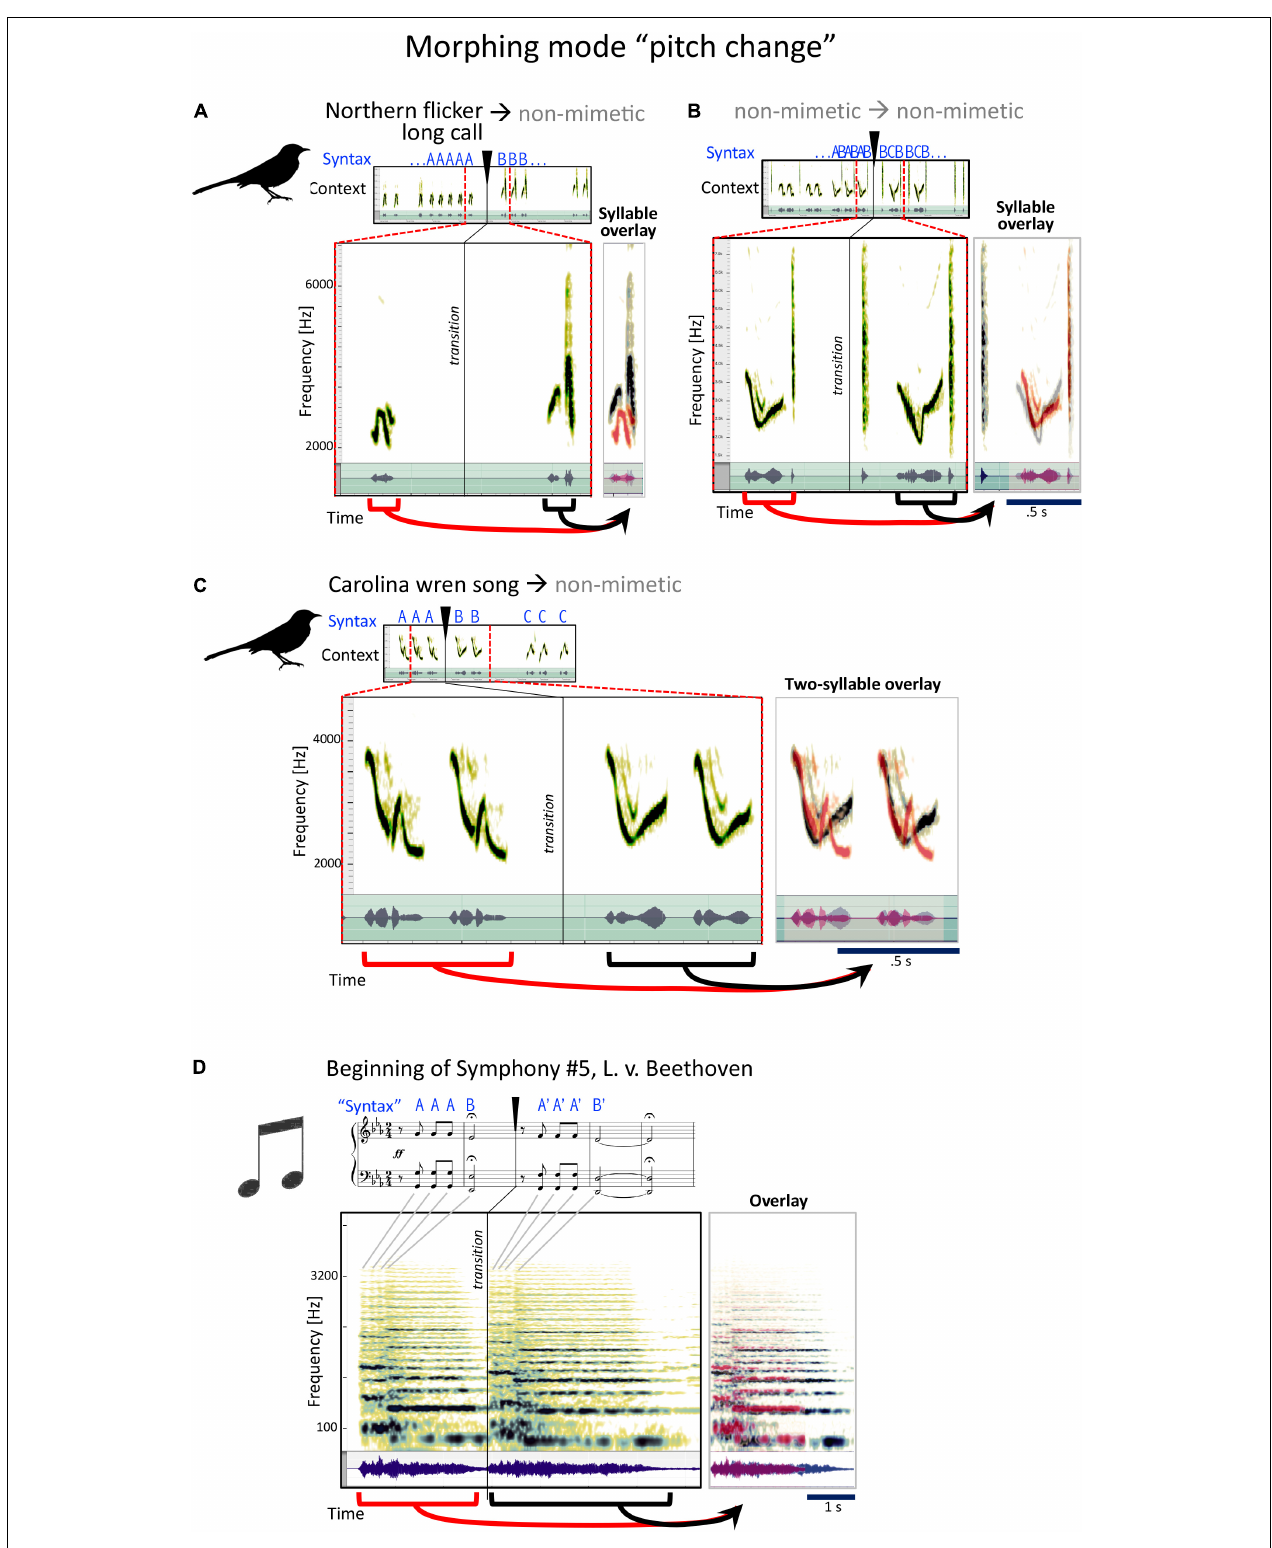
FIGURE 5 | Examples for the mockingbird morphing mode “pitch change,” and example for a similar musical strategy. (A–C) Spectrograms and waveforms (as in Figure 4 ) for three examples of phrase transitions representing “pitch” morphing, in which a phrase is followed by a phrase with similar syllables, the main difference being a modification in pitch. (D) The beginning of Beethoven’s fifth symphony follows a similar strategy, with a four-note sequence repeated with a different pitch.